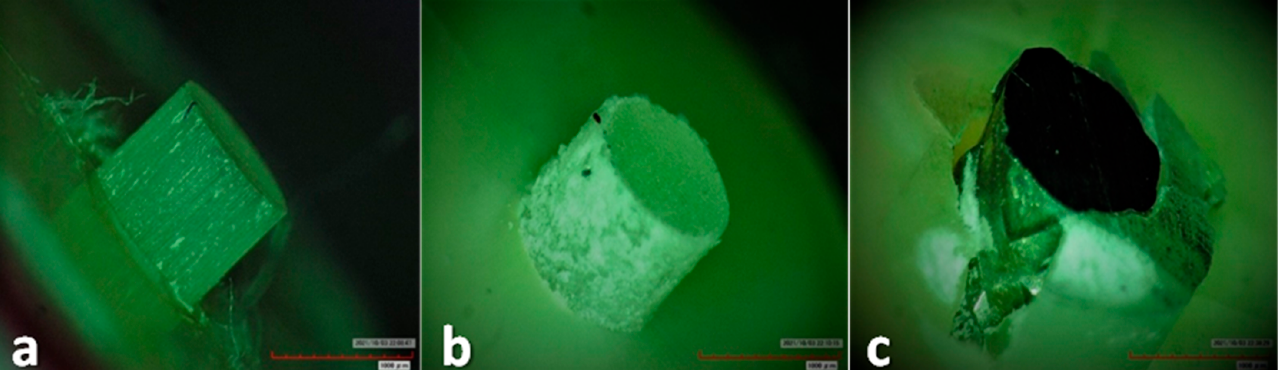
Figure 5. ( a ): Specimen attached to the universal testing machine for push-out test; ( b ): Close up view of the slice attached to push-out jig with plunger centered on the post.